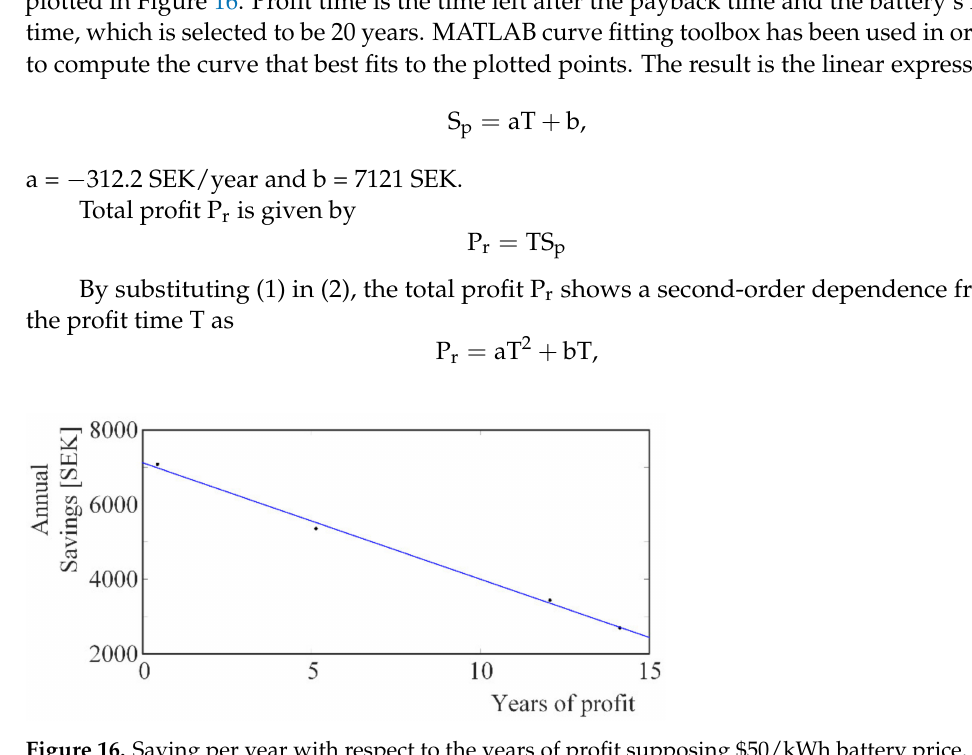
Figure 16. Saving per year with respect to the years of profit supposing $50/kWh battery price.